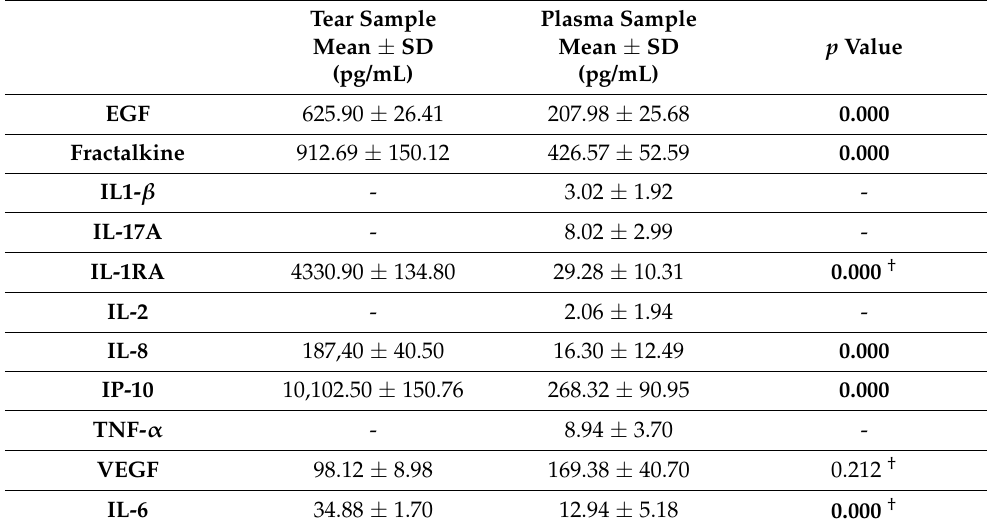
Table 5. Comparison of cytokine concentrations in tears and plasma in the inactive